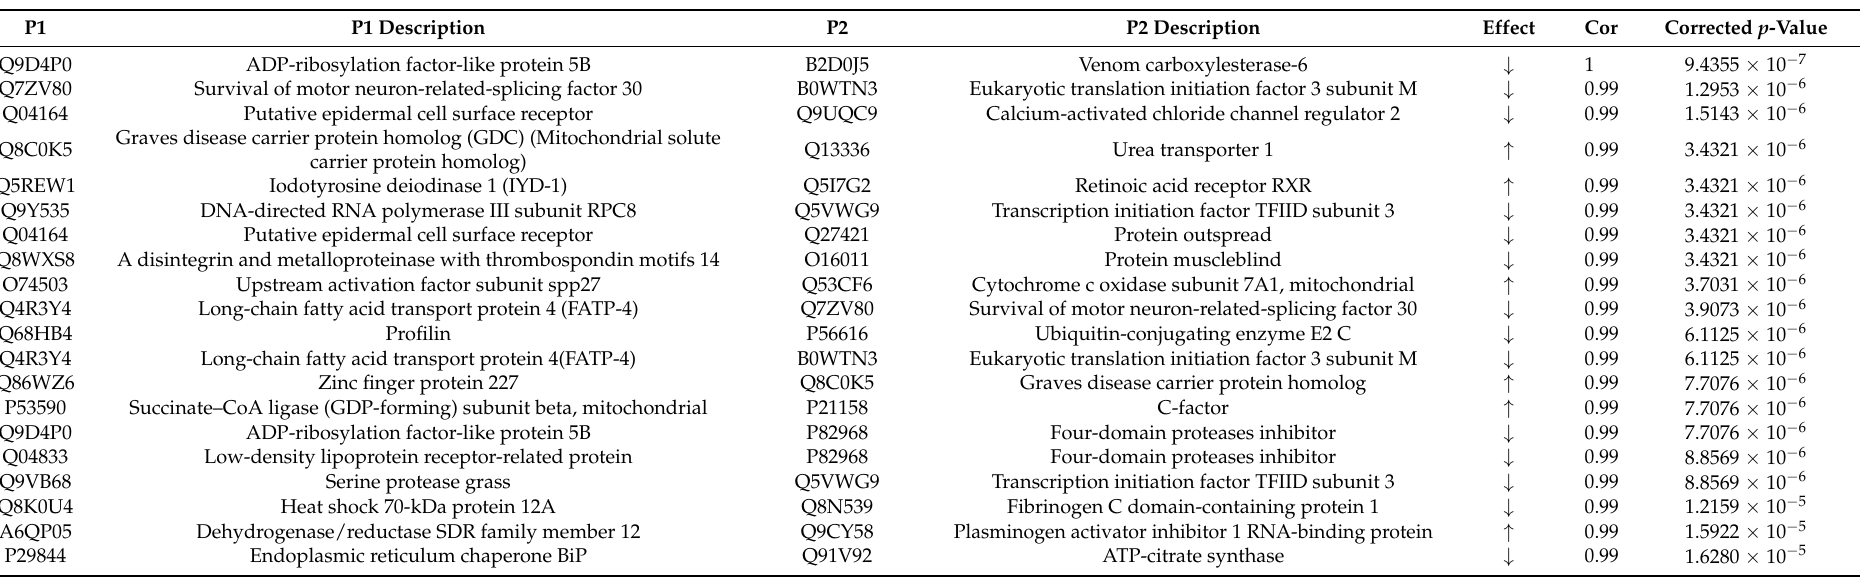
Table 2. Top 20 highly correlated differentially expressed transcripts (DETs). P1 and P2 represent the first and the second proteins in a correlated pair. Direction of the arrow represents whether the representative transcript is downregulated ( ↓ ) or upregulated ( ↑ ).